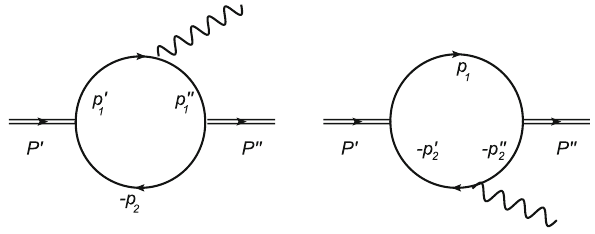
Fig. 1 Feynman diagrams for radiative transition 1 +− → 0 −+ + γ in the light-front